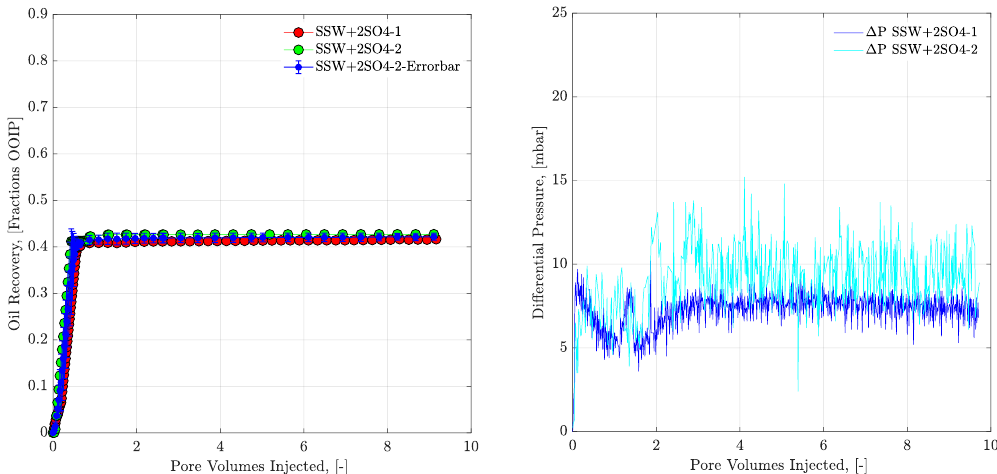
Figure 11. Oil recovery and pressure drop versus PV injected for artificial structure complex-wet micromodel. SSW+2SO 4 −2 injection is performed as the secondary mode for both flooding experiments.